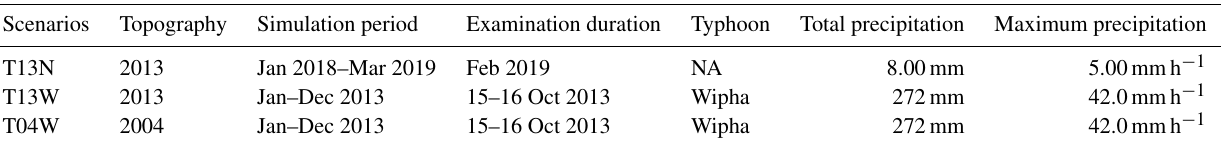
Table 1. Scenarios for the calibration, validation and quantification of the dynamic flood model. NA indicates there was no typhoon during the examination period. Total precipitation means the whole rainfall within the examination duration.